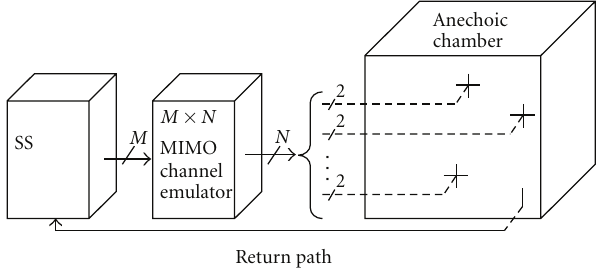
Figure 1: Multiprobe configuration (TR 37.976 [7] Figure 6 . 3 . 1 . 1-2).